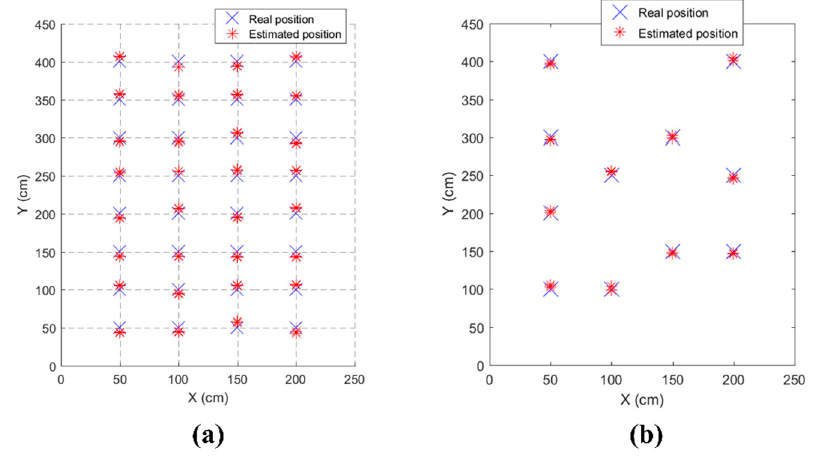
Figure 13. Positioning results for evenly and randomly distributed test points: ( a ) for evenly distrib- uted test points, positioning result at height 2 m; ( b ) for randomly distributed test points, position- ing result at height 2 m.